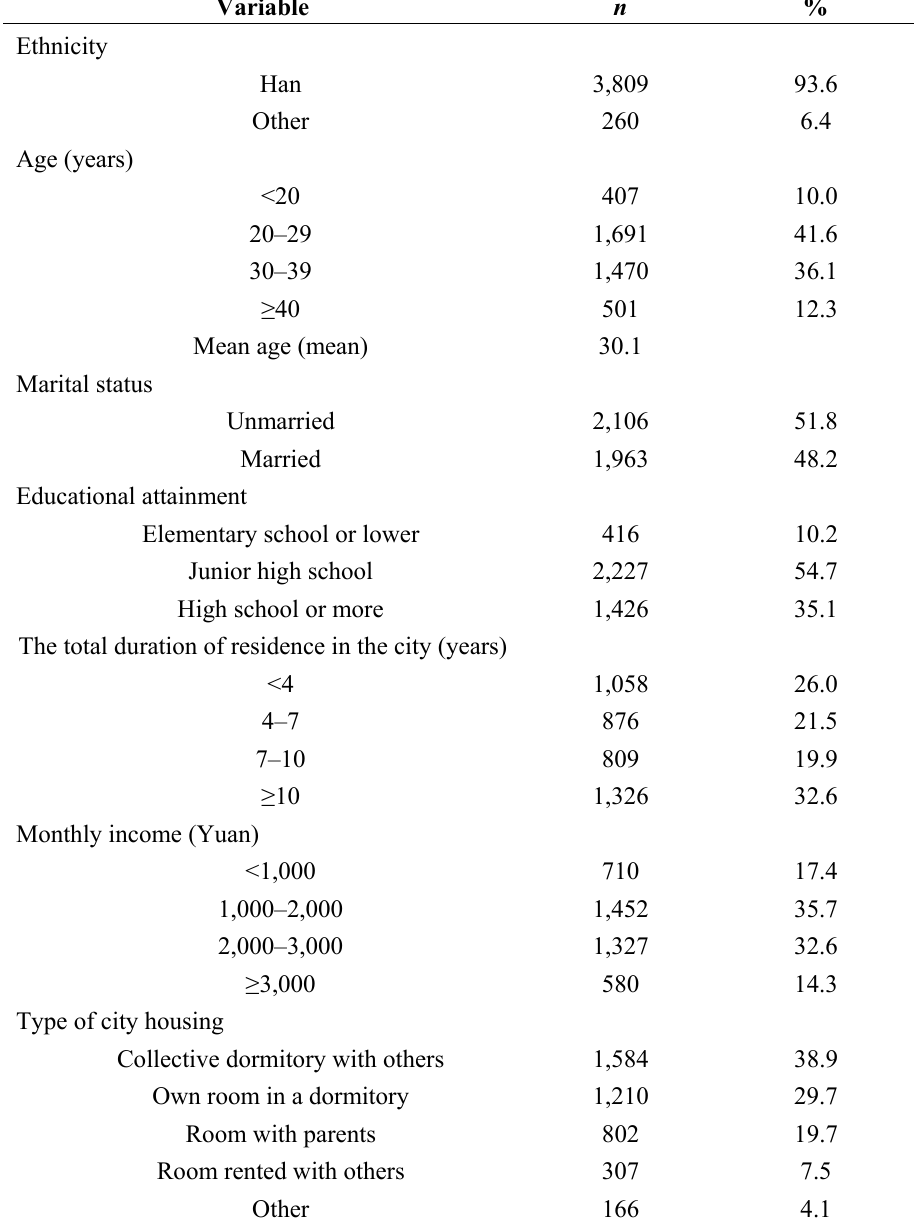
Table 1. Demographic characteristics of migrants ( n =